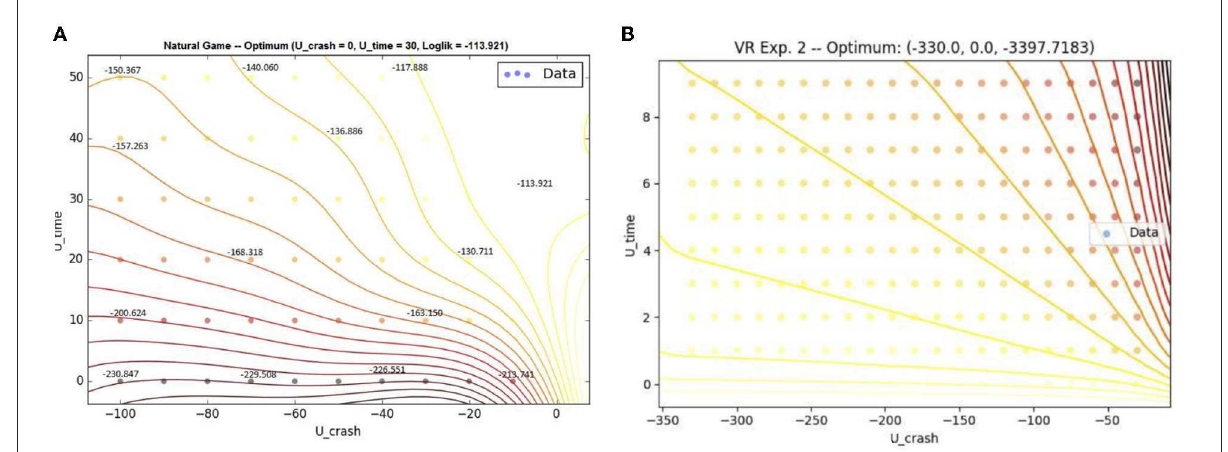
FIGURE8 (A) Gaussian Process posterior belief over values of time and collision inferred from the physical human pair game experiment (Camara et al., 2018d). The contour lines show heights of the belief function over the 2D space of possible joint values for ( U crash , U time ). The posterior appears approximately circumferentially symmetric, with its maxima along a ray from the origin to around ( − 10,50). (B) Gaussian Process posterior belief over values of time and collision inferred from the VR experiment (Camara et al., 2021). Circumferential symmetry is again approximately present, with the maxima now found around the horizontal ray from the origin to (–350, 0). This suggests that subjects become more concerned about collisions in VR than in the game.